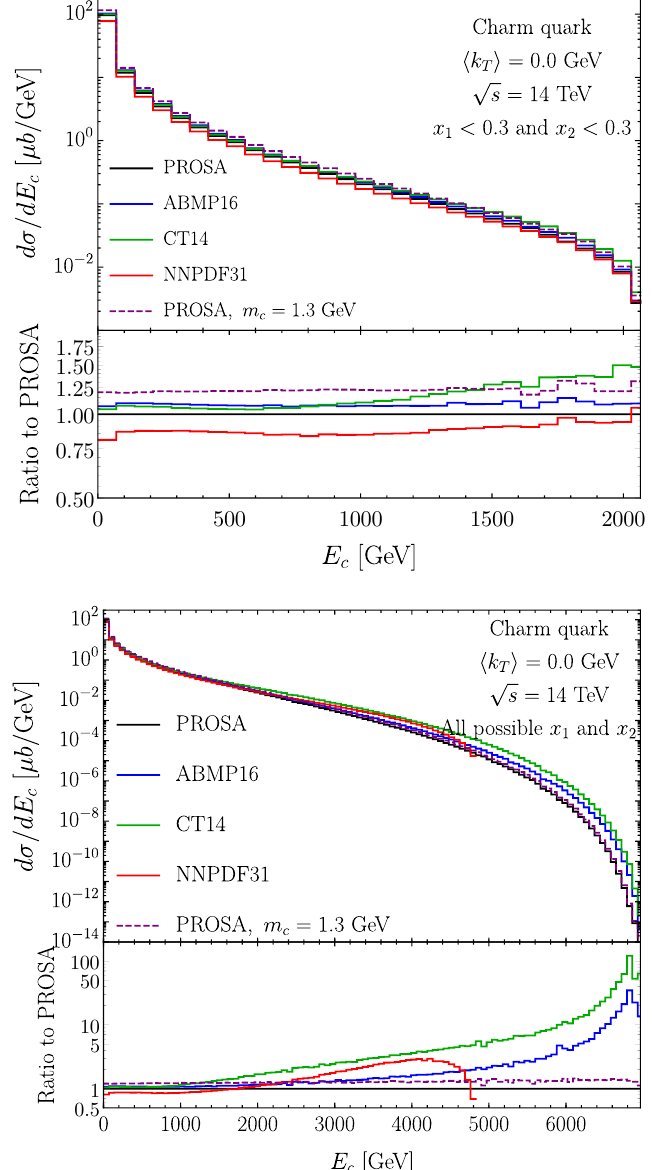
Figure 10. Charm energy distributions at NLO with h k T i = 0 , with x 1 and x 2 integrations limited to the range x 1 , x 2 < 0 . 3 (upper) and with full integration over all possible values of x 1 and x 2 (lower) for the central predictions using as input the PROSA, ABMP16, CT14 and NNPDF3.1 PDFs. The lower plots show the ratios of the charm energy distributions with respect to the prediction based on the central PROSA PDF, as a function of the charm